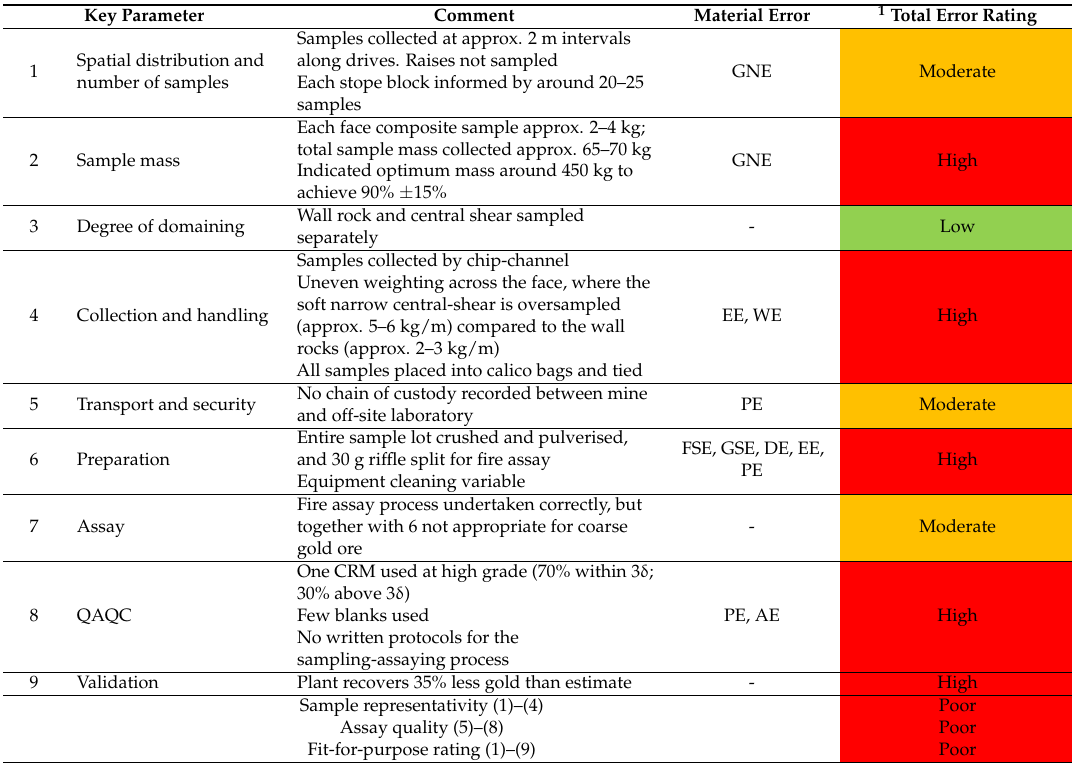
Table 26. Example of risk review for a grade control sampling programme used to support a resource estimate [6].